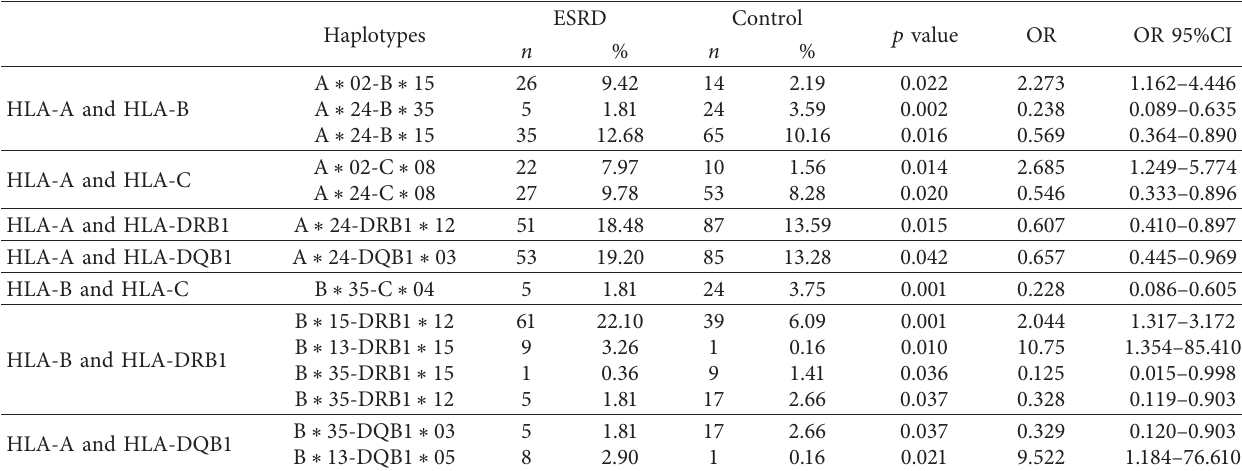
Table 3: Association of two-locus haplotypes with